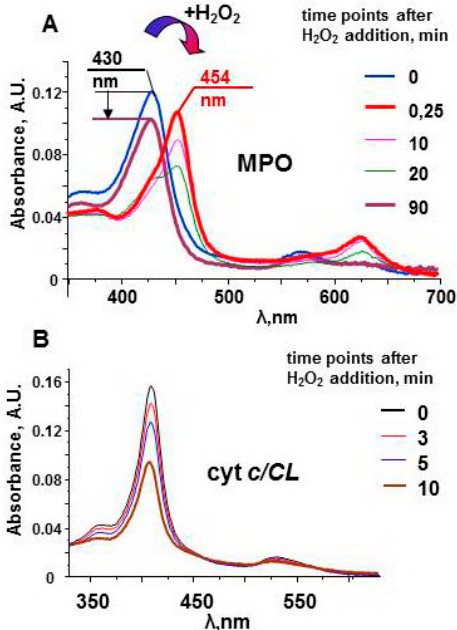
Figure 3. Optical spectra of myeloperoxidase and Cyt c /TOCL complexes after addition of H 2 O 2 [51,97]. ( A ) Upon addition of an excess of H 2 O 2 (200 µ M), MPO (1.2 µ M) undergoes conversion from its native form (the Soret band maximum at 430 nm) to Compound II having the absorbance maximum at 454 nm. In the absence of peroxidase substrates the absorbance at 454 nm slowly decreases, and the peak shifts towards 430 nm. The arrow indicates a decrease in the Soret band intensity in 90 min after addition of H 2 O 2 to MPO. ( B ) A progressive decrease of the absorbance of Cyt c /TOCL during its auto-oxidation process initiated by the addition of 250 µ M H 2 O 2 to the solution of ferri-Cyt c (1.5 µ M, tetraoleoyl-CL 30 µ M). 50 mM sodium phosphate buffer, 100 mM NaCl, pH 7.4, 100 µ M DTPA.